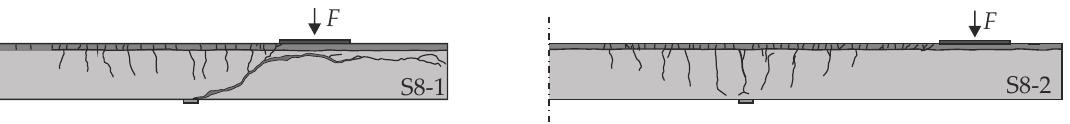
Figure 16. Crack patterns of cyclic tests on specimen